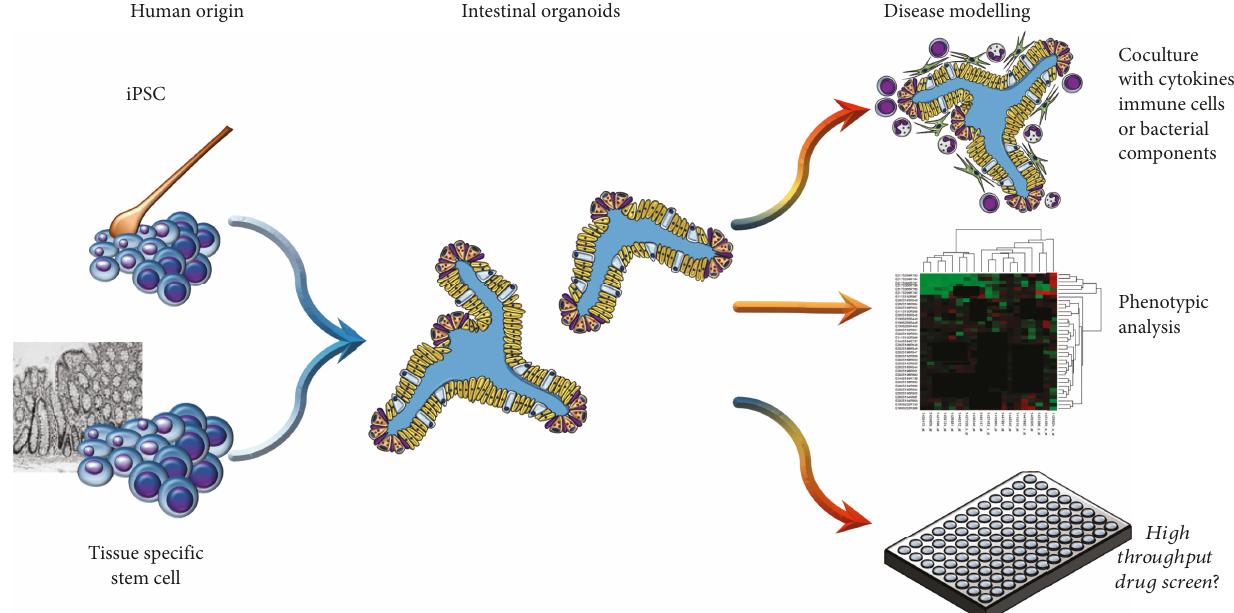
Figure 2: Derivation and potential use of intestinal organoids in IBD research. Induced pluripotent stem cells (iPSCs) can be derived from somatic cells, e.g., from pulled hair keratinocytes. Intestinal organoids then can be grown from iPSCs or from intestinal crypts and be used for disease modelling by coculture with in fl ammatory cells or bacteria, exposition to signaling molecules, or phenotypic analysis. Future applications could be the development of high-throughput drug screening